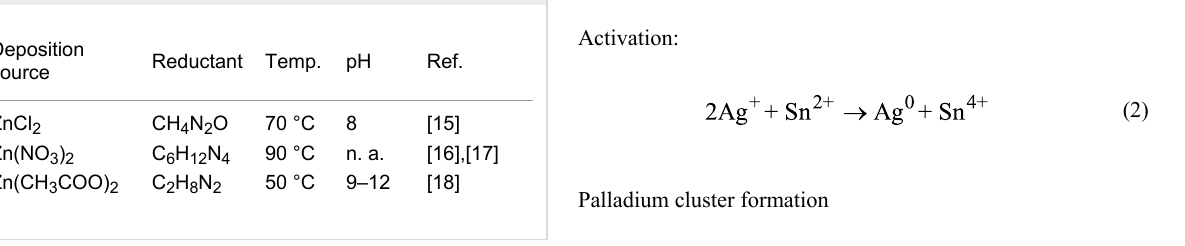
Deposition source